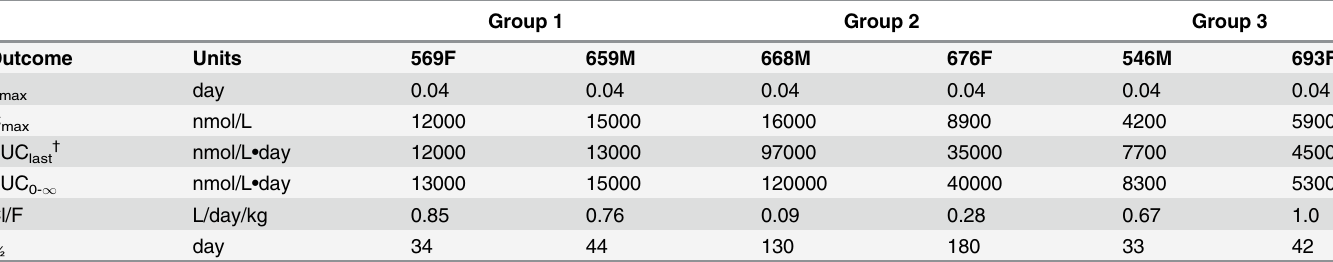
Table 5. Pharmacokinetics of DB829 in vervet monkeys with second stage HAT after the 5 th intramuscular